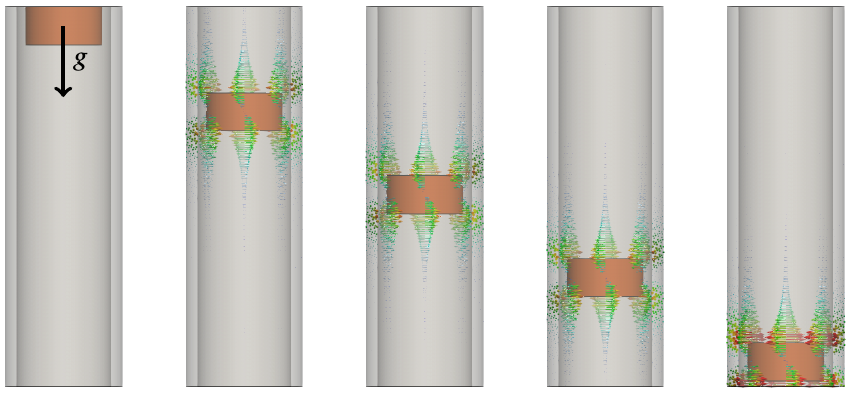
Figure 10. Falling magnet in a copper tube: snapshots with induced